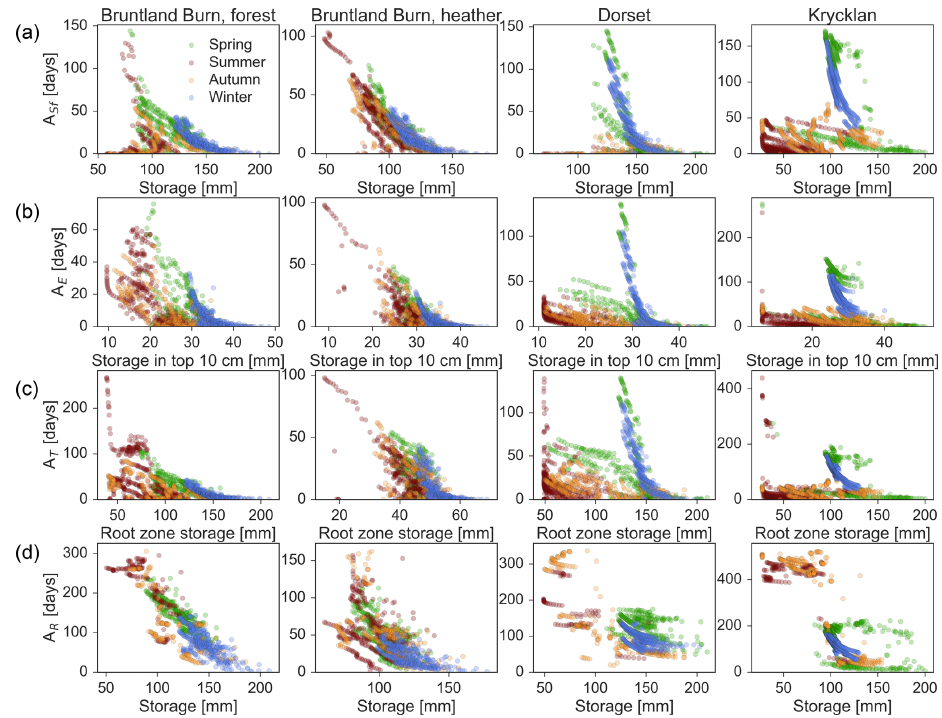
Figure 6. Median water age of fast flow domain ( A Sf , a ), evaporation ( A E , b ), transpiration ( A T , c ), and recharge flux ( A R , d ) as a function of the water stored in the entire soil, in the upper 10cm, in the root zone and in the entire soil profile, respectively. Each column represents one of the four studied sites. The dots show the relationship between water ages and storage for each day and the colour code represents the season of the corresponding days. Table 3. Summary of water age characteristics of the four study sites: median (25th percentile, 75th percentile) of the median water ages in the total storage ( A St ) , storage in the slow flow domain ( A Ss ) , storage in the fast flow domain ( A Sf ) , evaporation flux ( A E ) , transpiration flux ( A T ) , and recharge flux ( A R ) . Letters as superscript indicate significant differences in each column. Sites with the same letter are not significantly different regarding the water ages of the considered storage or